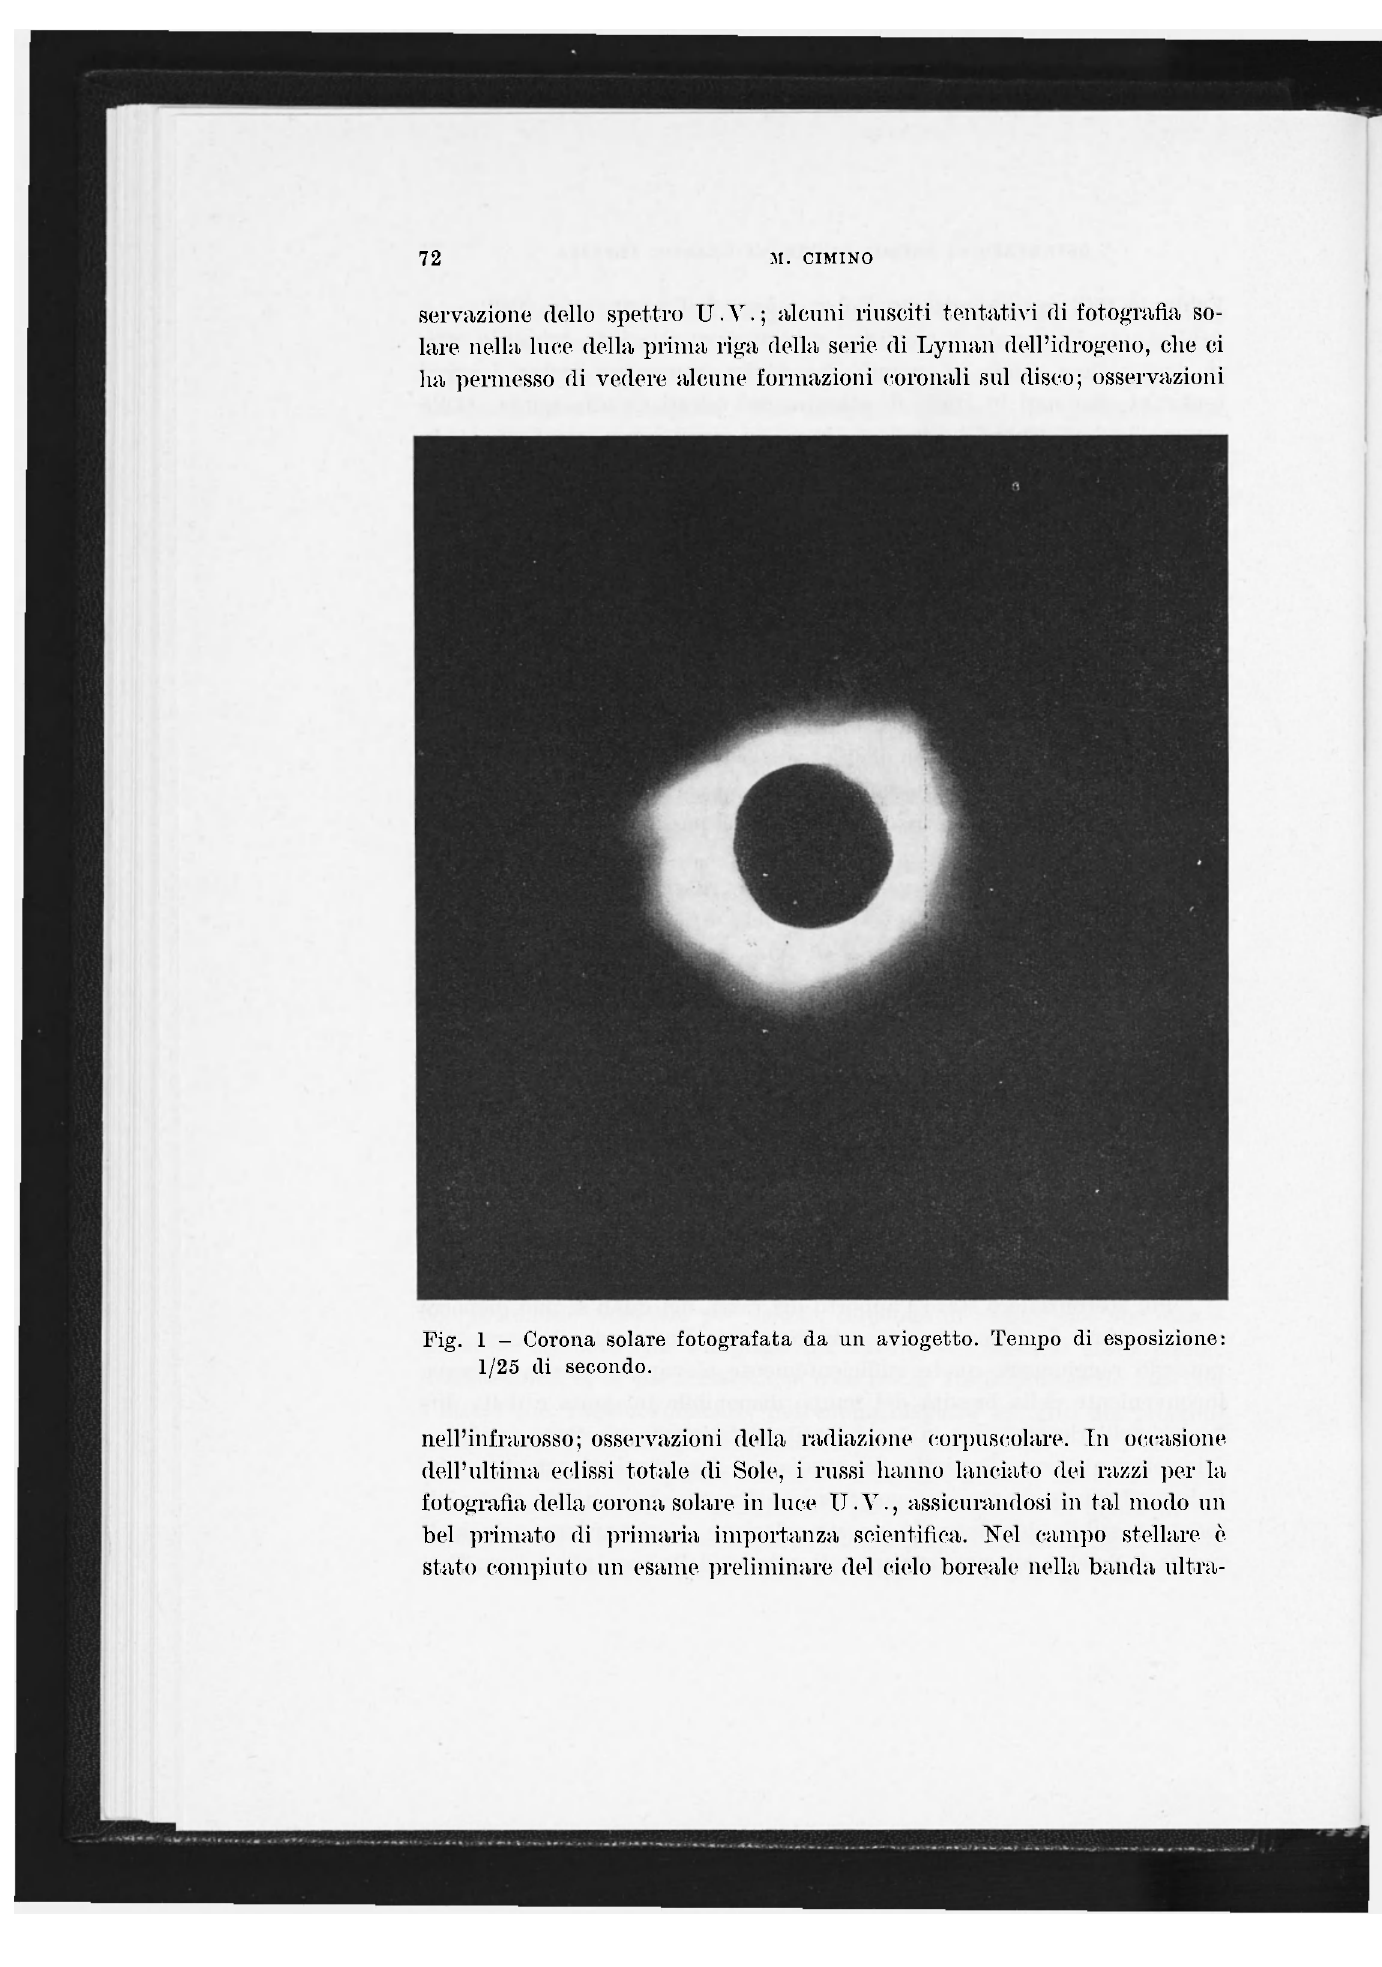
Fig. 1 - Corona solare fotografata eia un aviogetto. Tempo di esposizione: 1/25 di